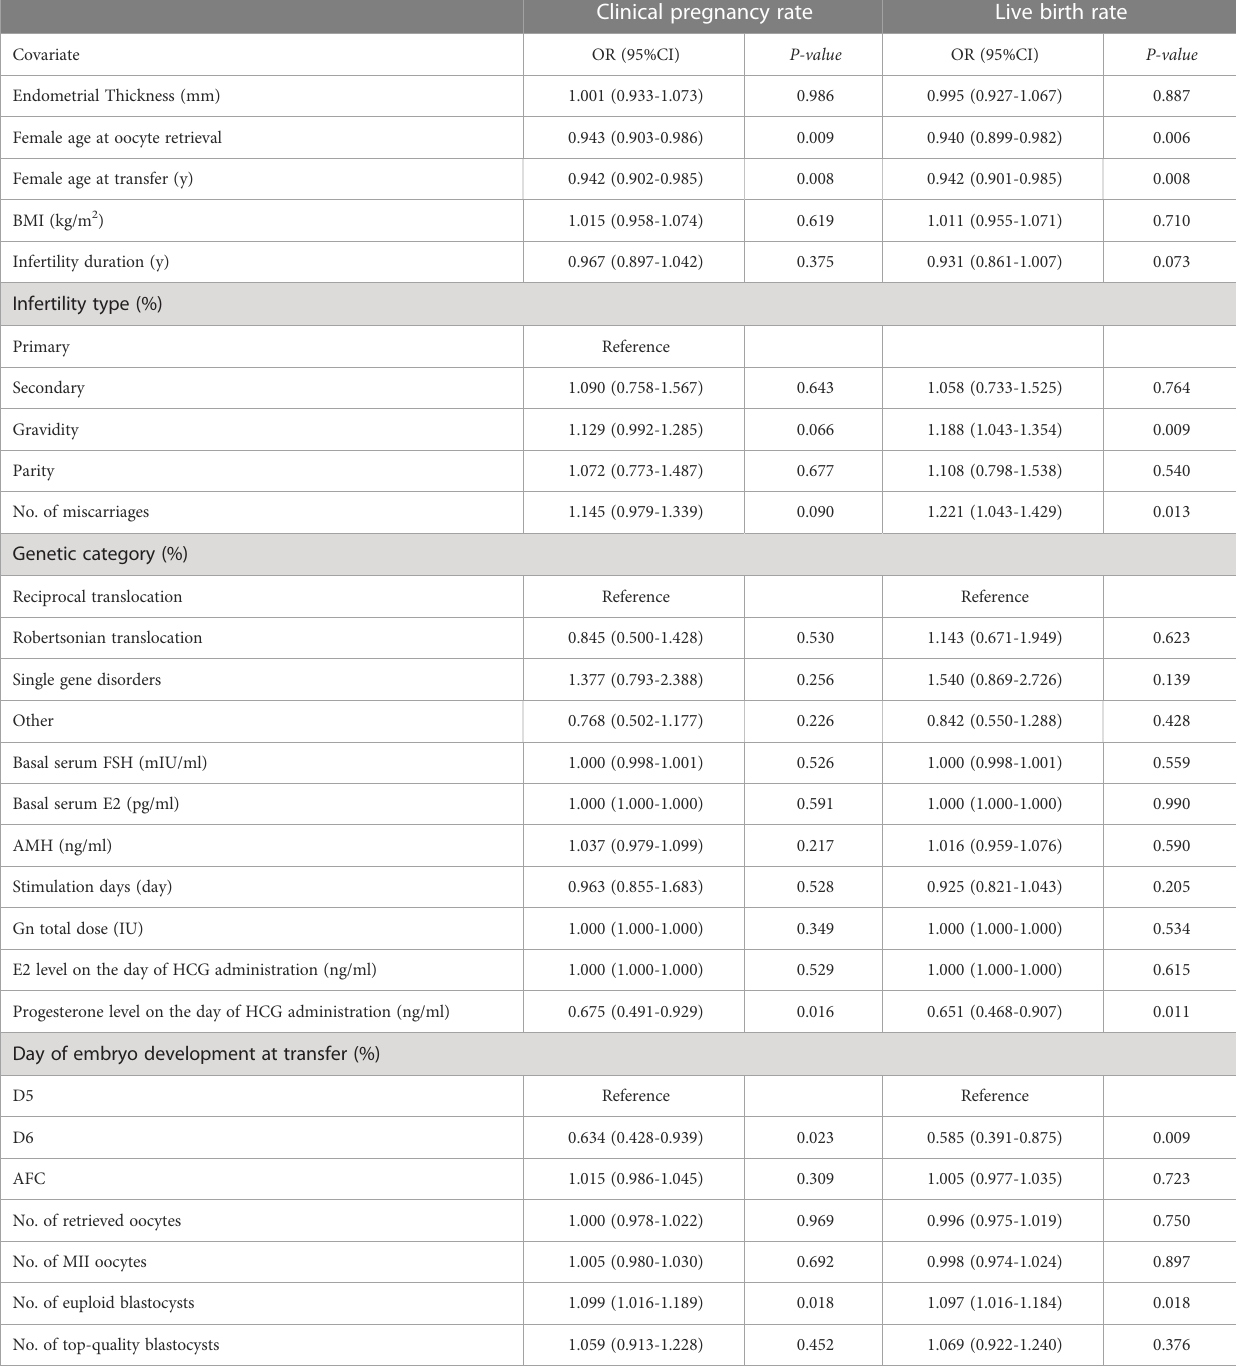
Clinical pregnancy